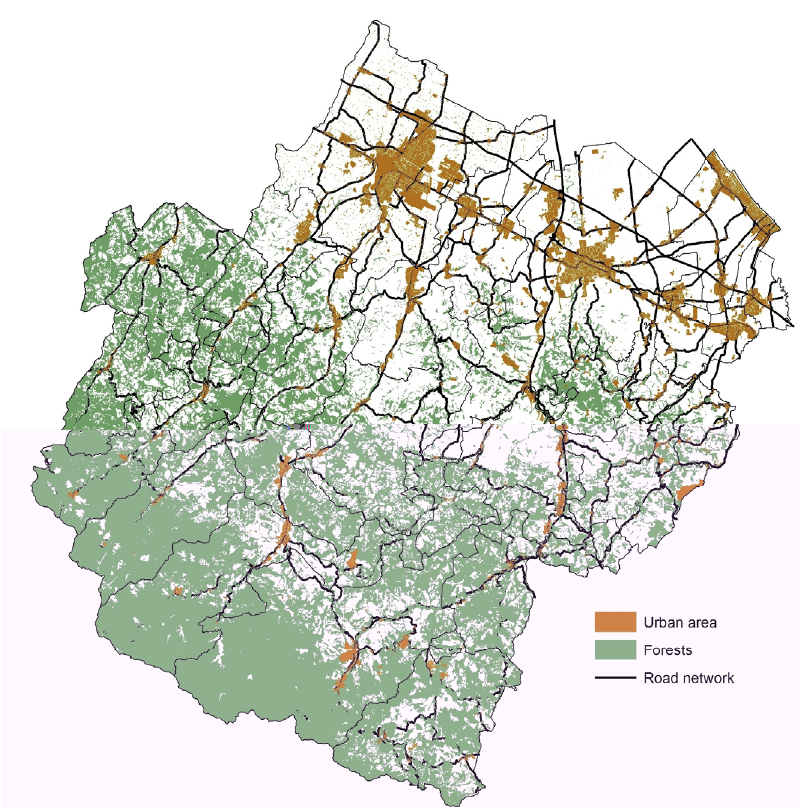
Figure 1. Map of Forlì-Cesena